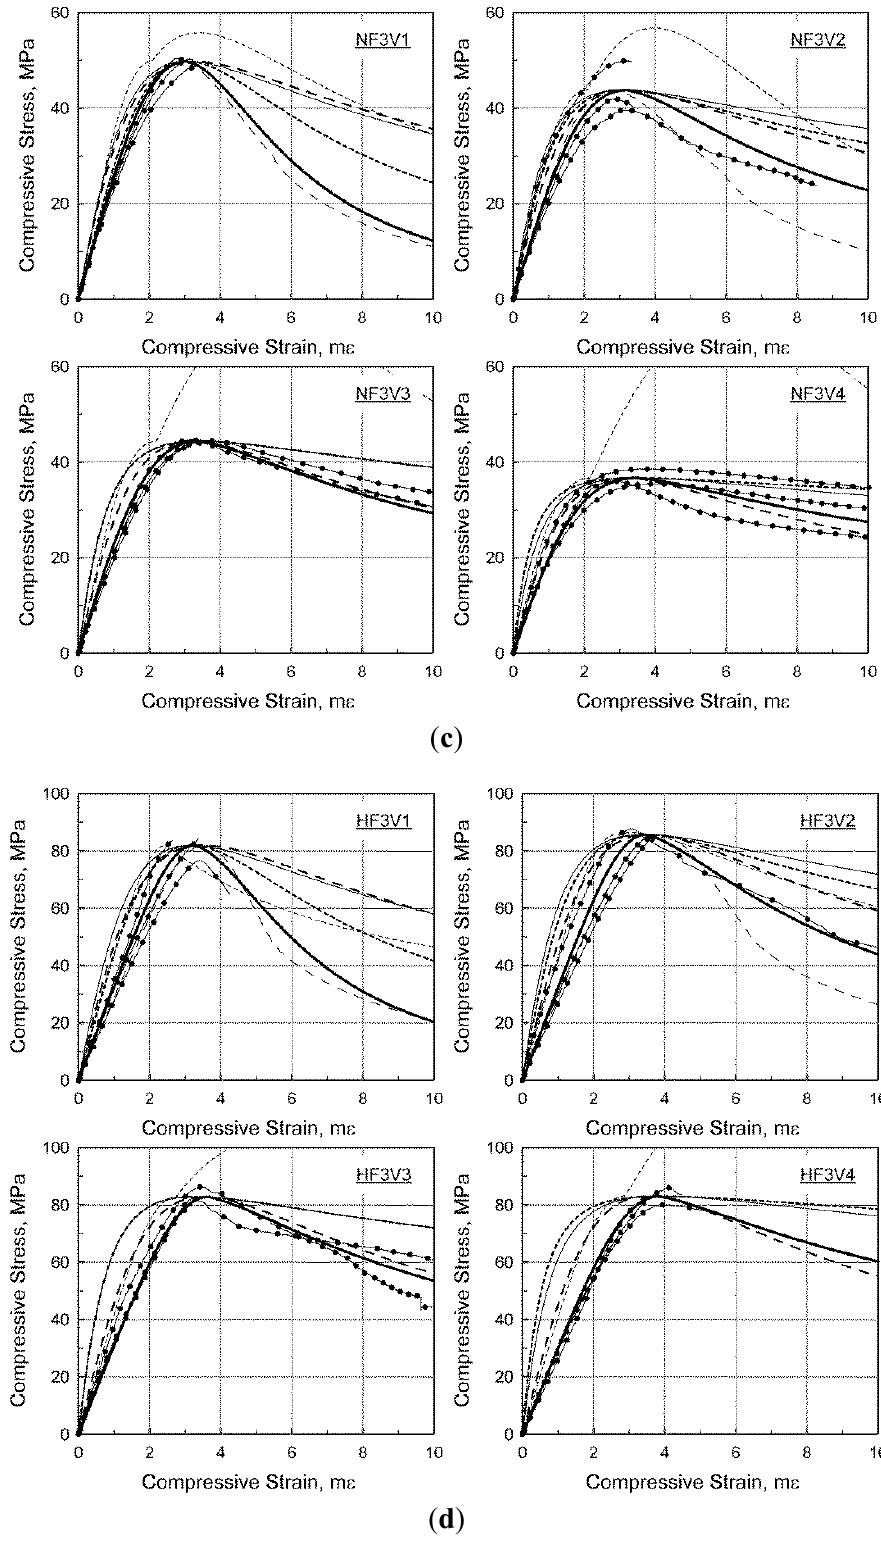
Figure 9. Comparison of the stress-strain response under compression. ( a ) NF1 series; ( b ) NF2 series; ( c ) NF3 series; ( d ) HF3